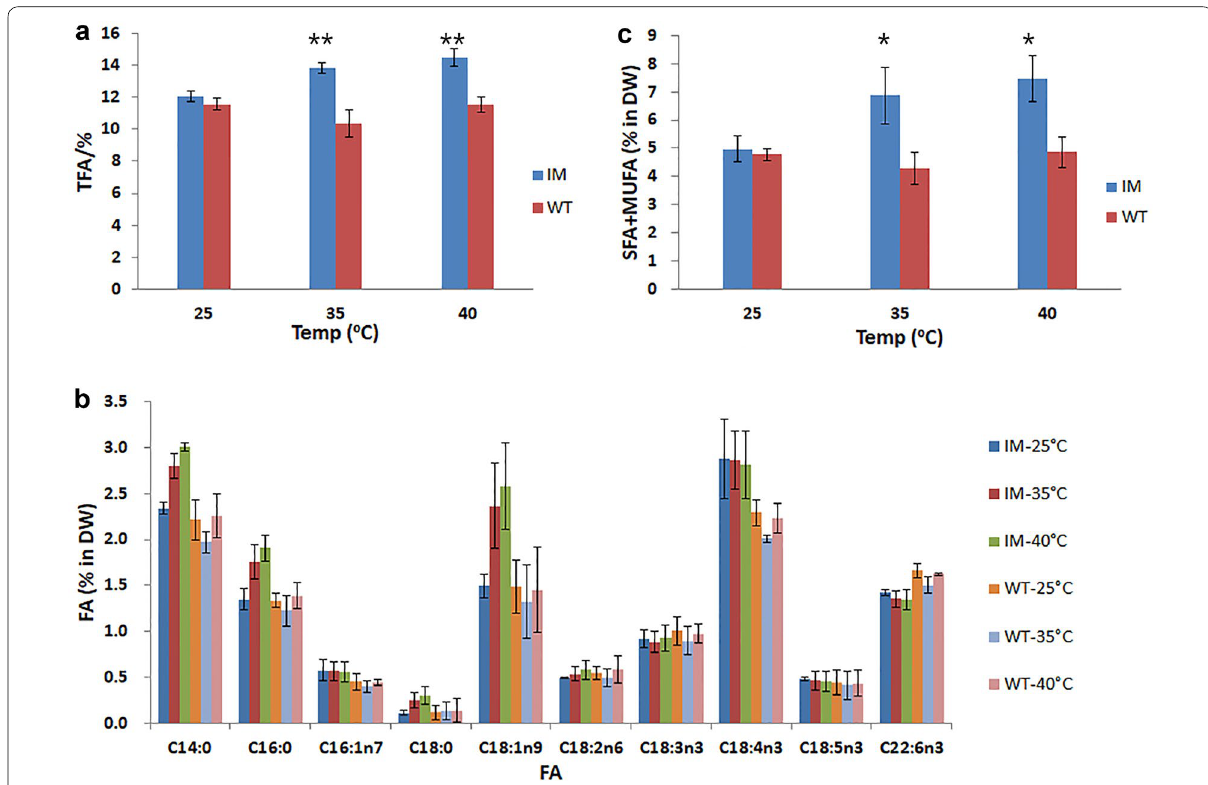
Fig. 4 Total fatty acids and fatty acid content (% DW) of WT and IM at 25, 35 and 40 °C. a Total fatty acids (% DW). b Saturated and monounsaturated fatty acids. c Fatty acid content (% DW) *p < 0.05; **p < 0.01. All points represent the mean